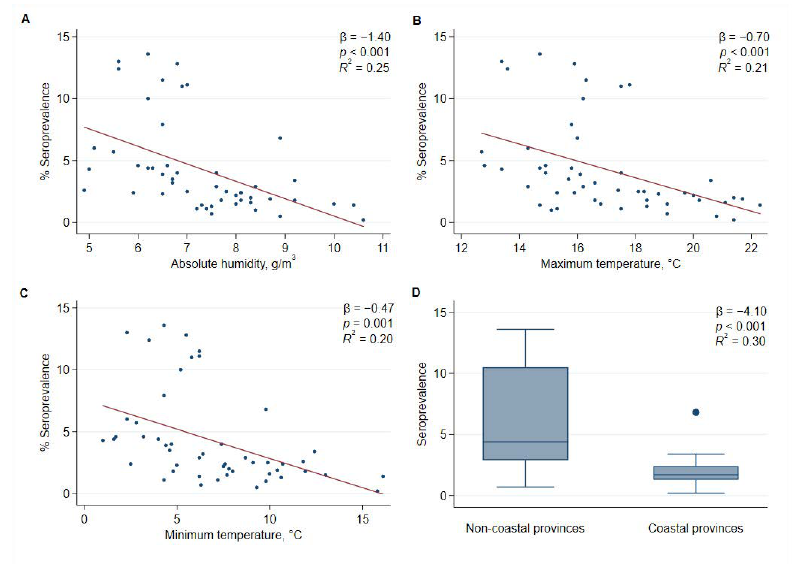
Figure 1. Bivariate association of the seroprevalence of IgG antibodies against SARS-CoV-2 as a function of four environmental parameters by province. The seroprevalence was obtained by immunoassay tests in samples collected from 27 April to 11 May 2020, in Spain. ( A ) Average of absolute humidity; ( B ) average of daily maximum temperatures; ( C ) average of daily minimum temperatures; and ( D ) box-plot of comparison between coastal and non-coastal